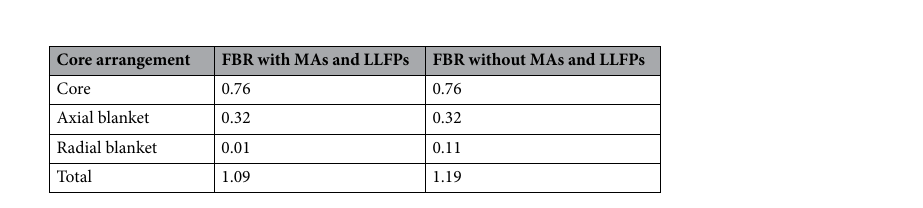
Table 4. Comparison of breeding ratios with and without MAs and LLFPs.